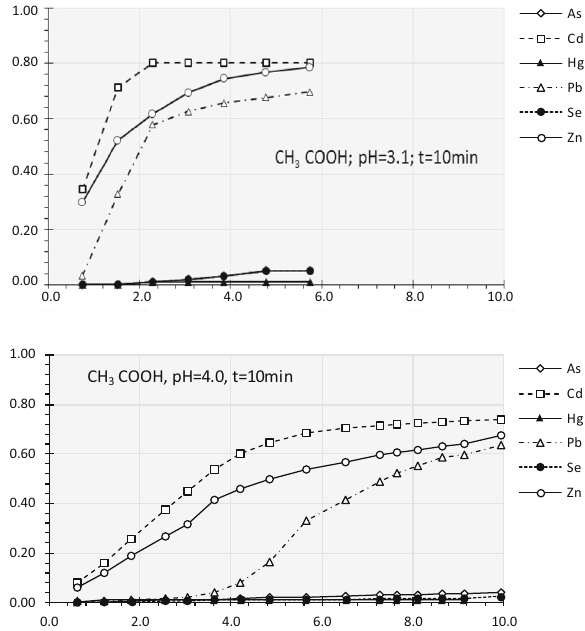
Fig. 9 Extraction yield versus volume (L) for t = 10 min and pH = 3.1 and 4.0